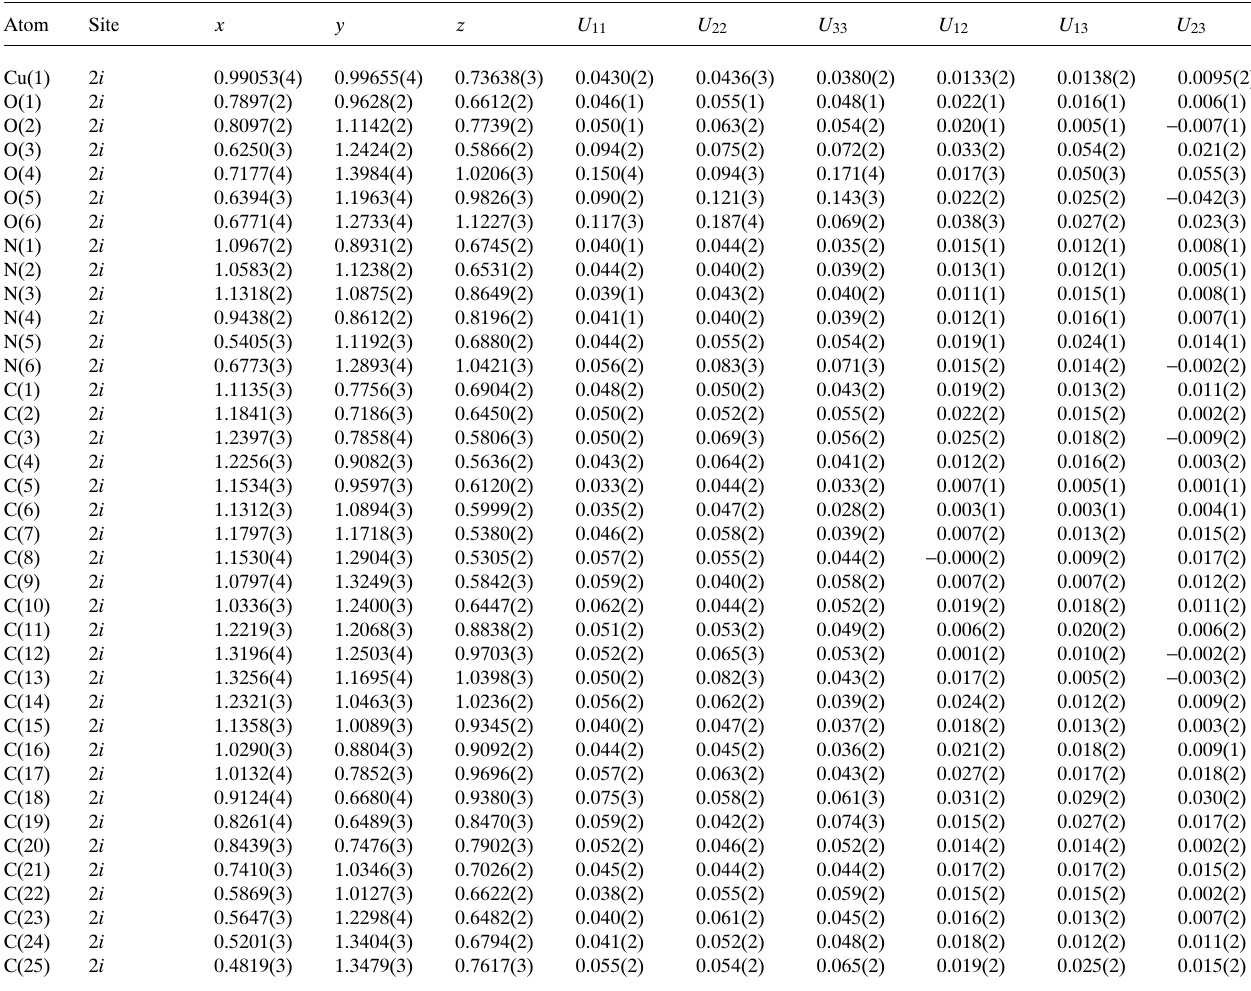
Table 3. Atomic coordinates and displacement parameters (in Å 2 ) .